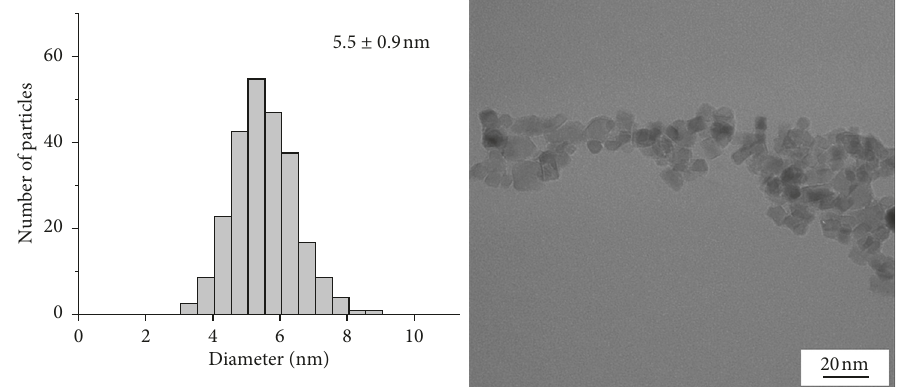
Figure 3: Ethyl cellulose encapsulated CeGdZn-ferrite by polymer emulsion.